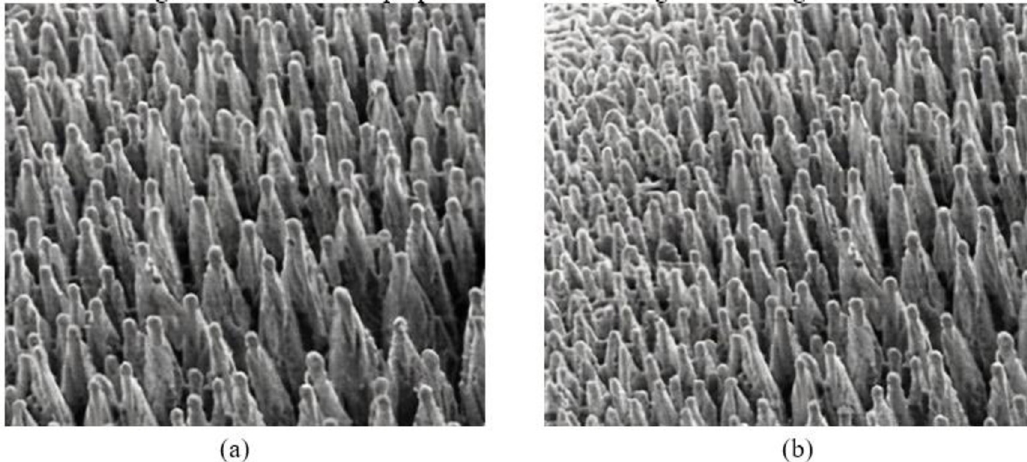
Fig 5. Scanning electron microscope diagram of FS-based black silicon (a. background gas is SF 6 ; b. background gas is N 6 ).